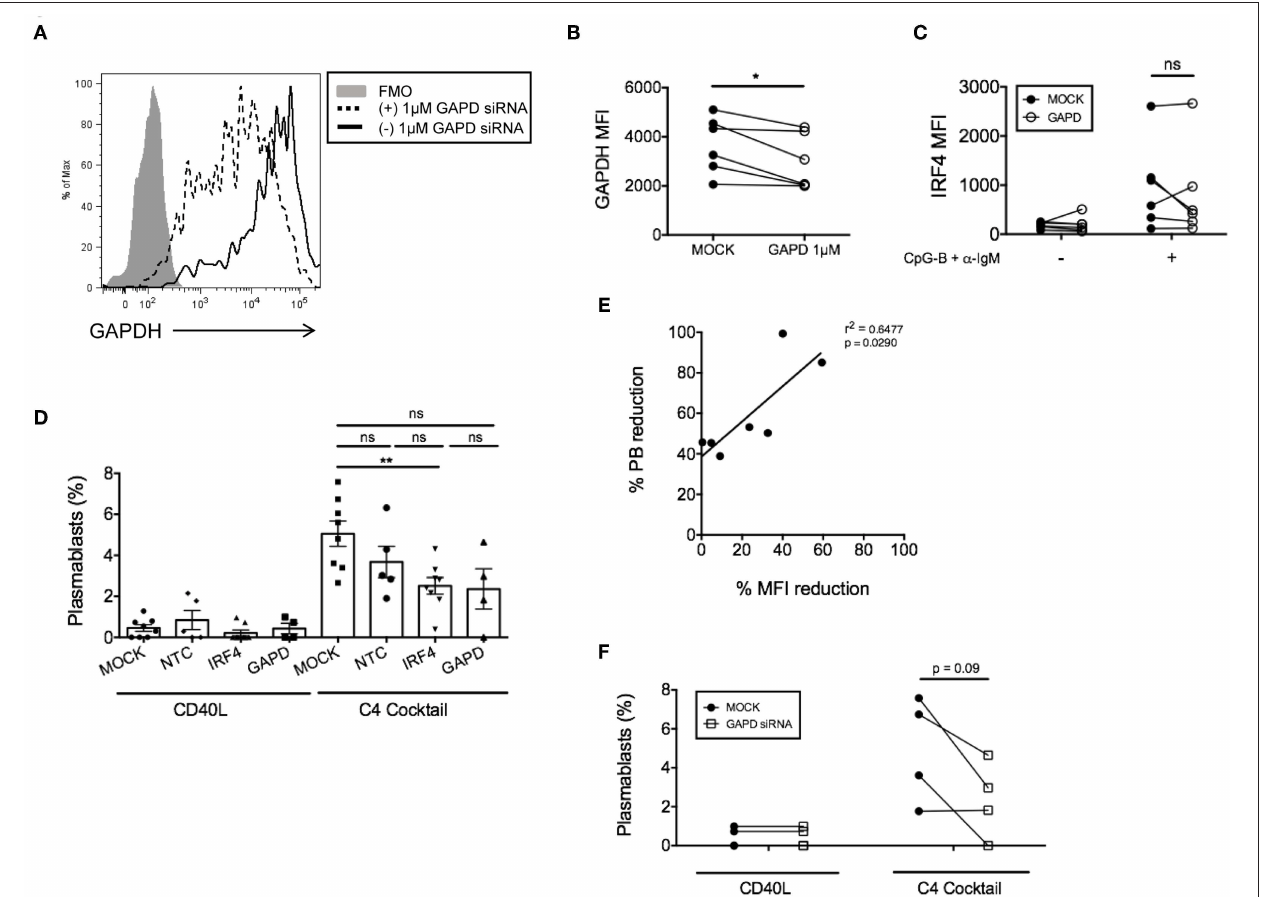
FIGURE 3 | GAPD housekeeping gene as a positive control for nucleofection. (A) Representative figure showing histogram overlay of B cells nucleofected with 1 µ M GAPD siRNA and then cultured for 48h post-nucleofection. (B) Paired dots show the efficiency of GAPDH knockdown in CD19 + IgD − B cells from matched independent donors after 48h culture ( n = 6). (C) Same as (B) except IRF4 expression was determined after nucleofection with 1 µ M GAPD siRNA ( n = 6). (D) Naïve B cells were cultured for 7 days with the C4 cocktail (anti-IgM + CpG-B + IL-21 + CD40L) to induce plasmablast differentiation post-nucleofection with 1.5 µ M GAPD siRNA, 1.5 µ M IRF4 siRNA or 1.5 µ M NTC siRNA. Plasmablast differentiation was determined by flow cytometry analysis of CD19 + IgD − CD27 + CD38 + cells ( n = 9). Bars represent mean ± SEM. (E) Correlation between % plasmablast reduction and % IRF4 MFI reduction. (F) Effect of GAPD siRNA on % plasmablasts from (D) are shown as paired dots to indicate matched donor effects. Paired t -test for significance was performed (* p < 0.05).